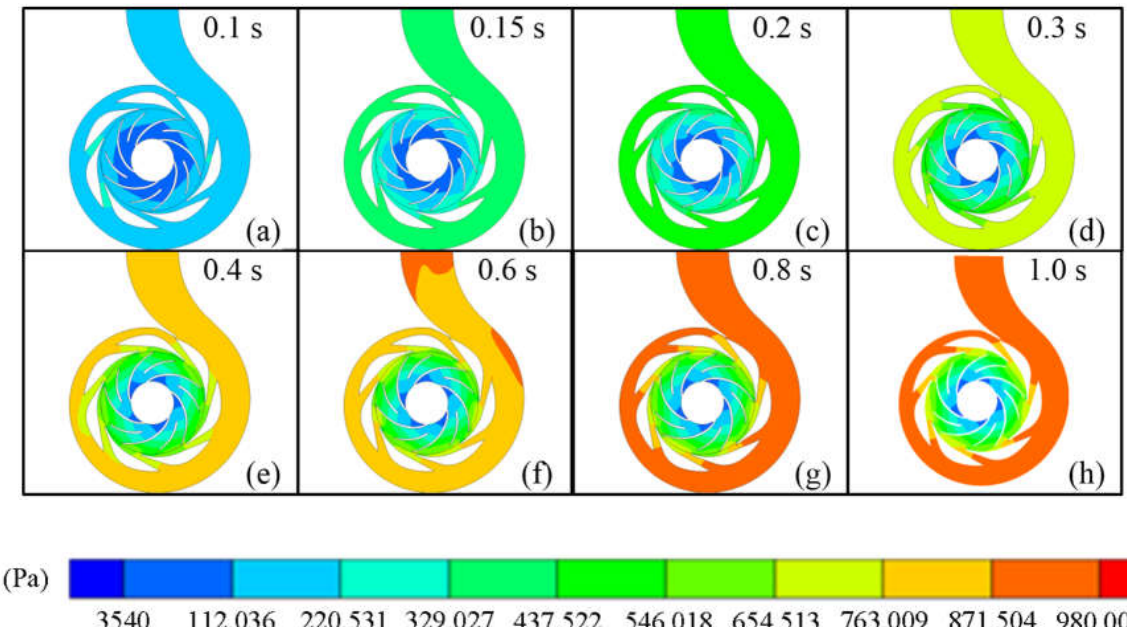
Figure 10. Schematic diagram of the pressure distribution during the startup process: ( a ) t = 0.1 s ( b ) t = 0.15 s ( c ) t = 0.2 s ( d ) t = 0.3 s ( e ) t = 0.4 s ( f ) t = 0.6 s ( g ) t = 0.8 s ( h ) t = 1.0